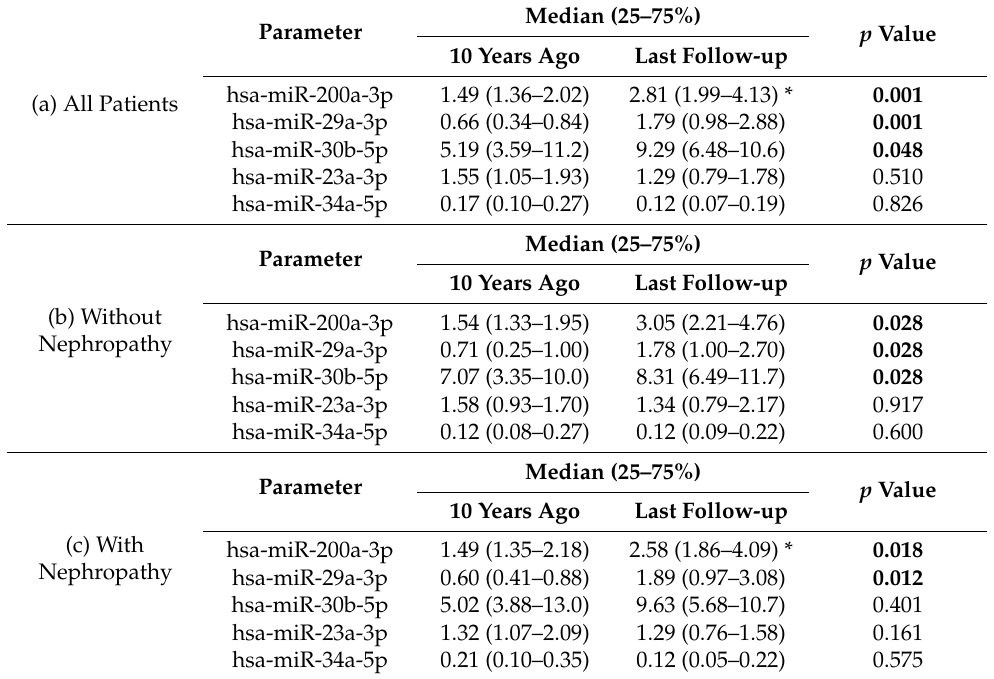
Table 8. Fold changes in the expression of miRNAs in (a) all patients ( n = 14), (b) patients with- out nephropathy ( n = 6), and (c) patients with Fabry nephropathy ( n = 8) in samples collected approximately 10 years